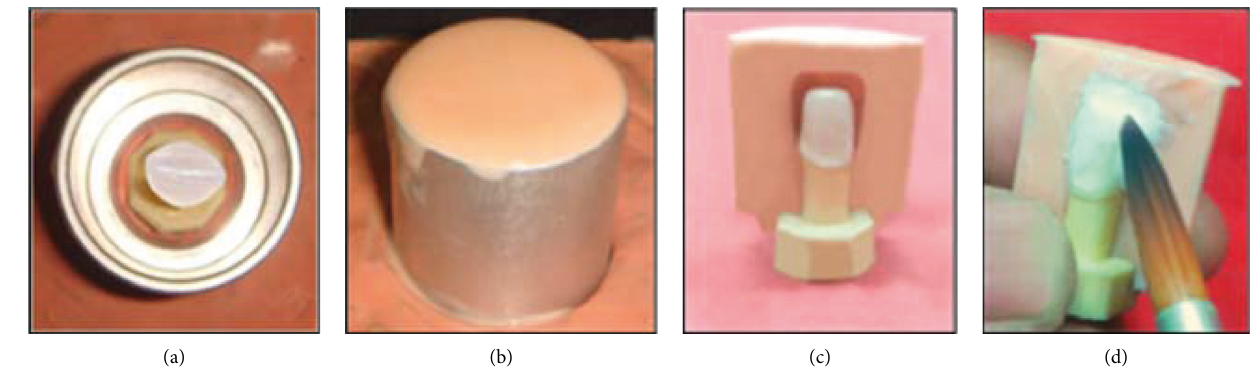
Figure 3: Making impression of full contoured CAD/CAM zirconia crown: (a) CAD/CAM zirconia coping inside the metal ring; (b) metal ring filled with the duplicating material; (c) split mold adapted on lined zirconia coping; (d) application of body porcelain and condensation.